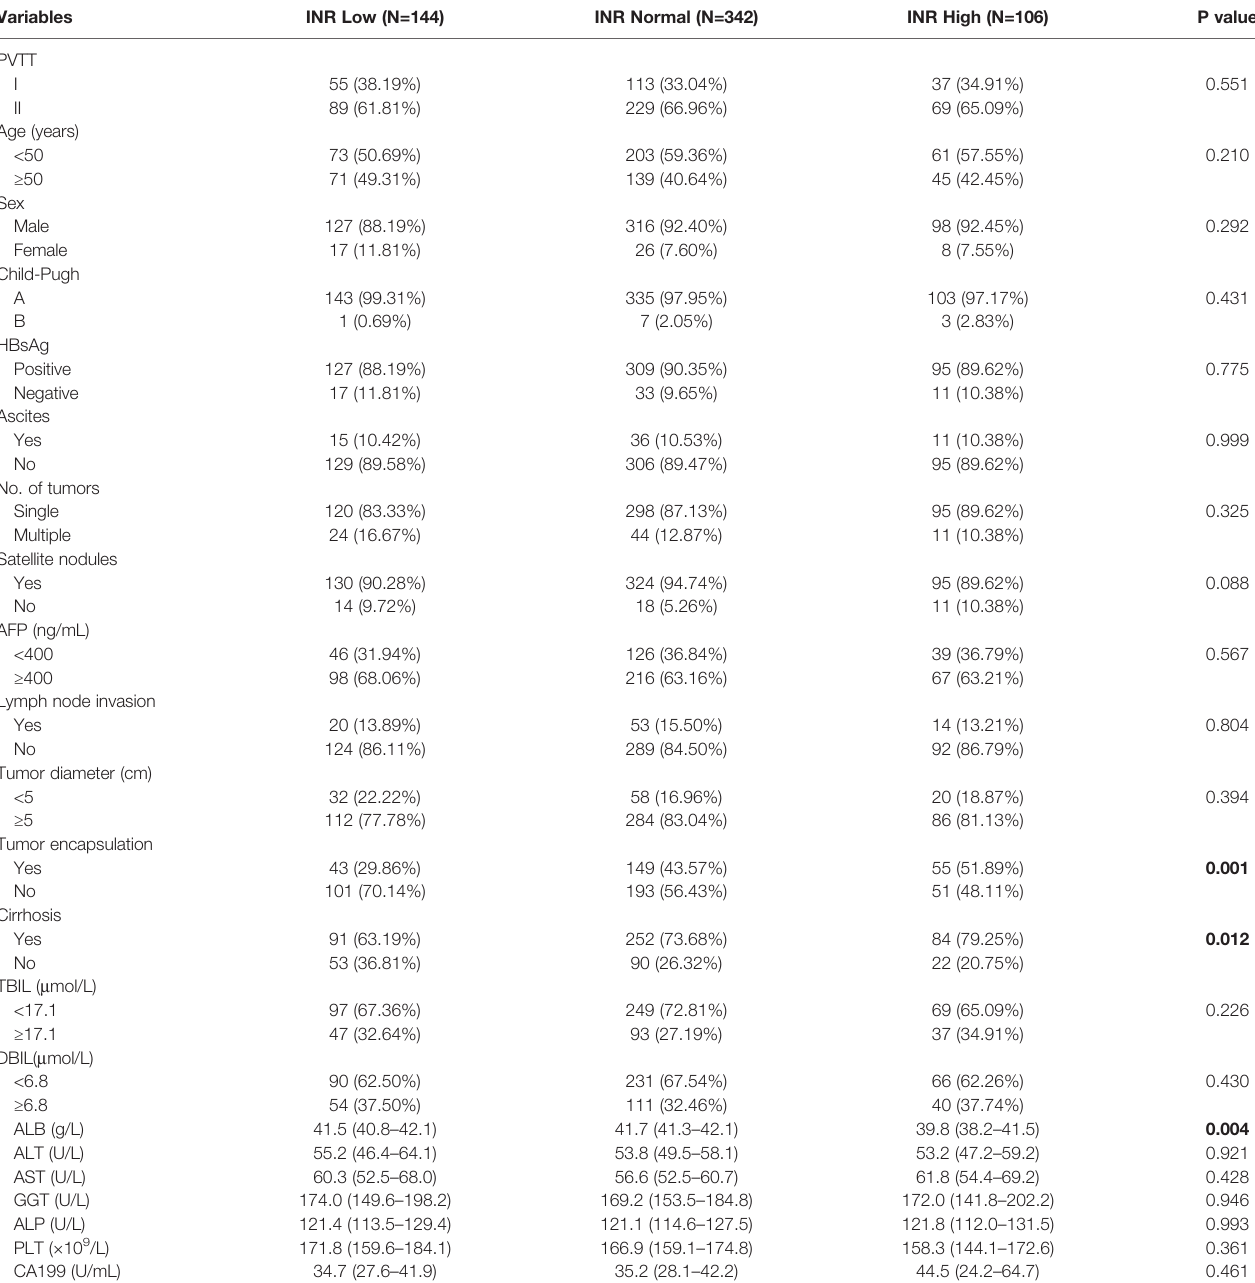
TABLE 1 | The clinicopathological features of HCC patients with types I/II PVTT who underwent R0 LR (n=592).